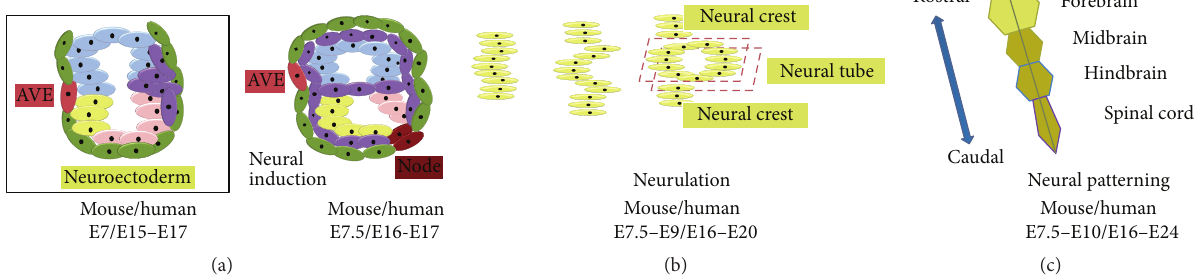
Figure 2: Neural induction, neurulation, and neural patterning overview. (a) Neural induction: neuroectoderm (neural plate) differentiation happensundertheinfluenceoftheAVE.Themesodermalcellsstartmigratinginalldirectionsandenveloptheembryobetweentheendoderm and the ectoderm. At the distal pole of the embryo the node develops, to further act as the “trunk organiser.” (b) Neurulation: from the neural plate, cells start to proliferate and invaginate in order to form the neural tube and neural crest which derives from the dorsomedial borders of the neural folds. (c) Neural patterning: cells from the neural tube start to differentiate into precursors for forebrain, midbrain, hindbrain, and spinal cord according to a rostrocaudal axis. All timelines are given for mouse and human embryonic